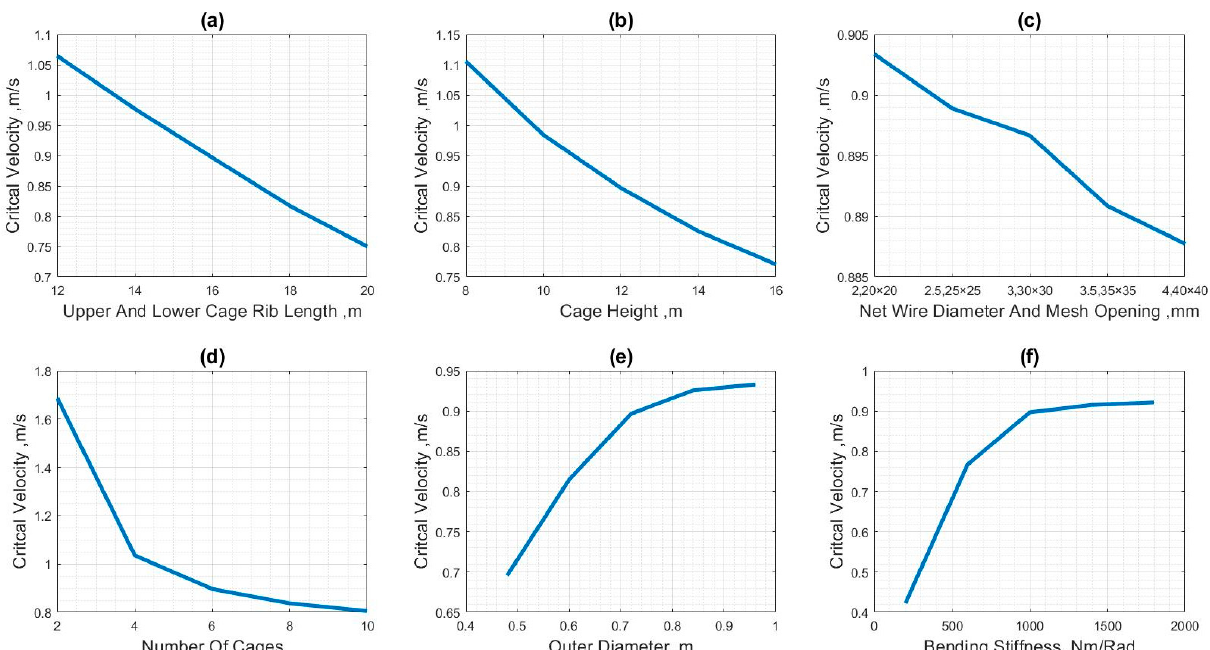
Figure 10. The critical buckling velocity for the Drift State as a function of: ( a ) the cage length (and width), ( b ) the cage height, ( c ) the net mesh, ( d ) the number of cages, ( e ) the outer diameter of the upper floatation pipe and ( f ) the connector spring stiffness.